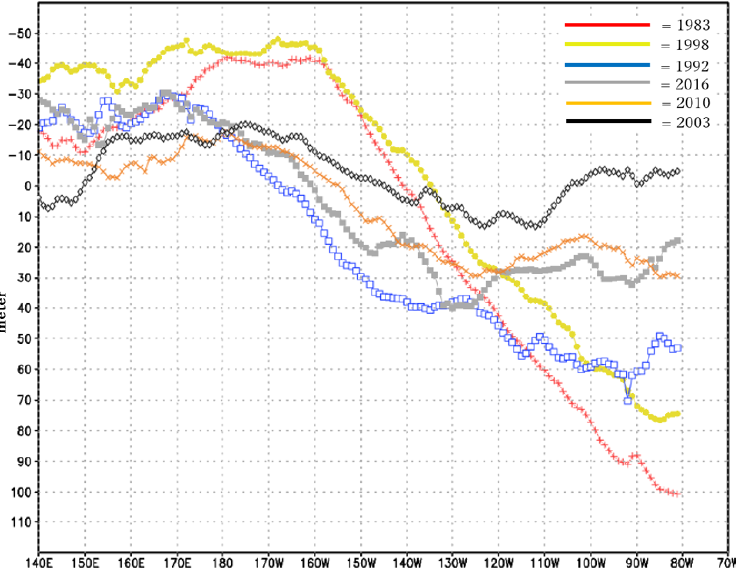
Figure 11. Equatorial Pacific D20 anomaly for January. Each type of El Niño was represented by two events; 1983 and 1998 representing EP type; 1992 and 2016 representing MIX type; 2003 and 2010 representing CP type.